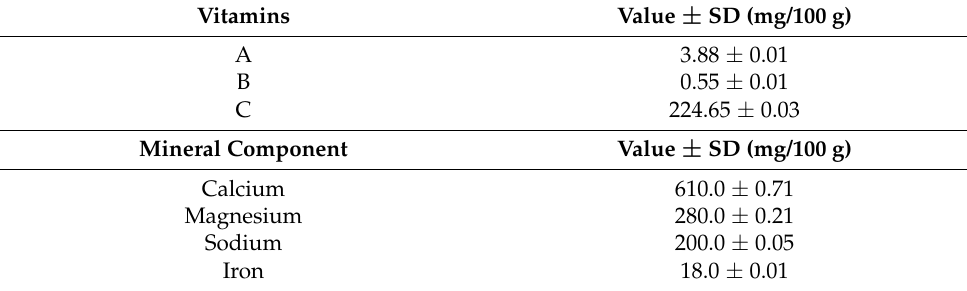
Table 6. The vitamin and mineral content of baobab fruit beverages.